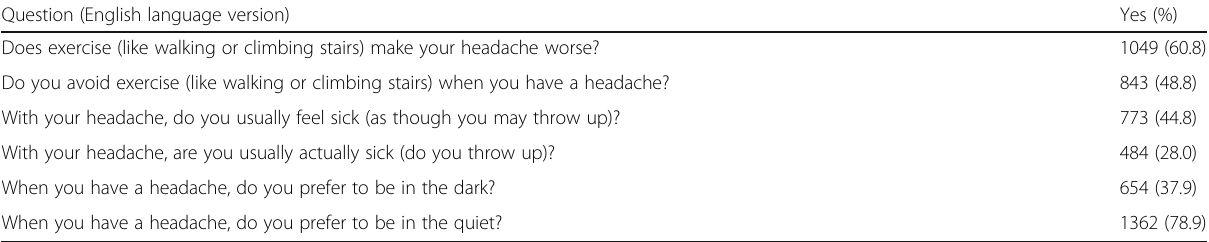
Table 3 Frequencies of positive responses among participants with headache ( n = 1726) to questions contributing to a diagnosis of